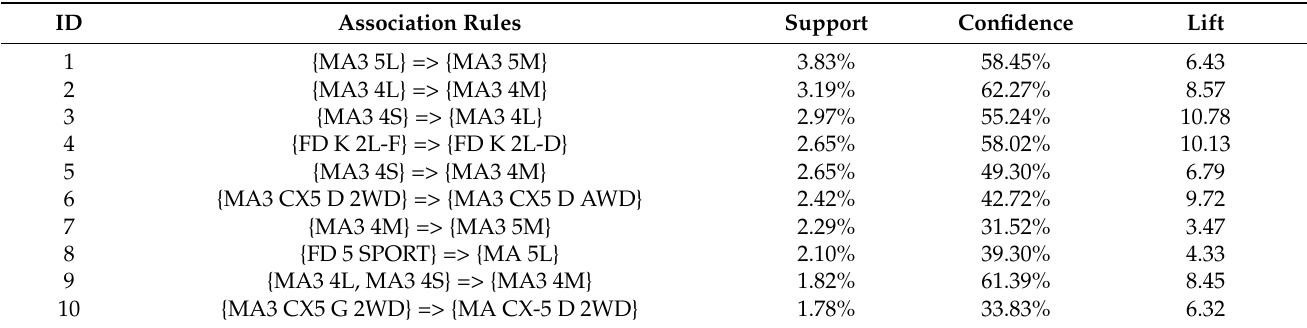
Table 4. Association rules